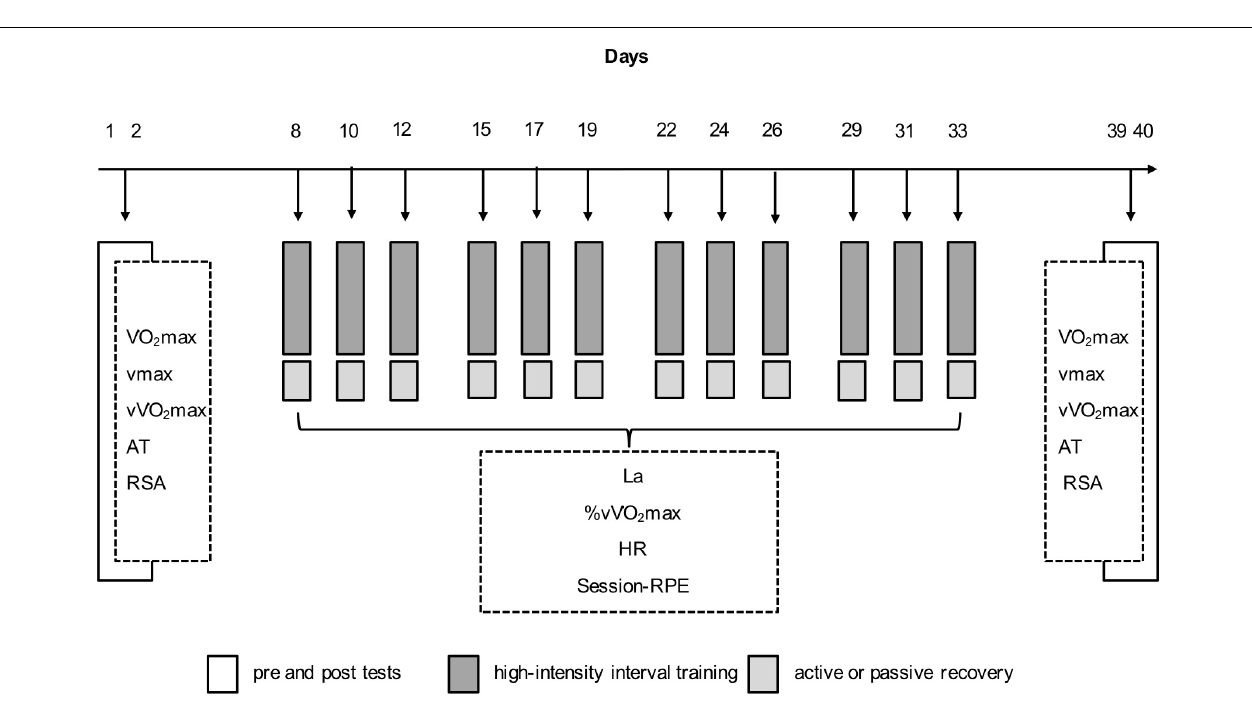
FIGURE 1 | Experimental protocol showing the measurements [maximum running velocity (vmax); running velocity at which maximal oxygen consumption occurs